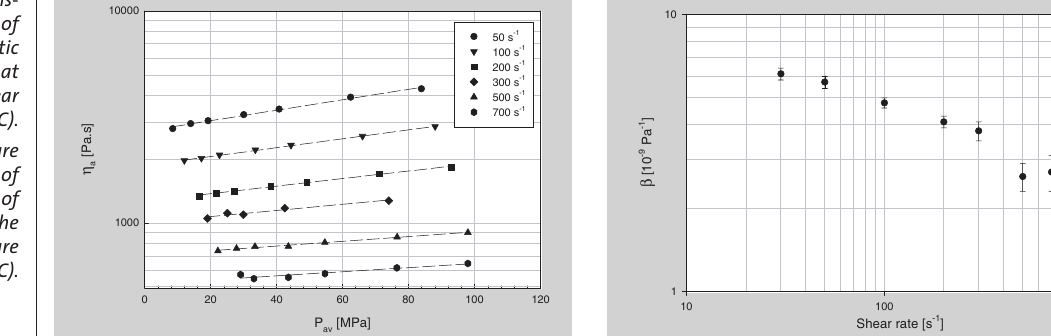
Figure 5 (left): Apparent vis- cosity as a function of increasing hydrostatic pressure for a LLDPE at different shear rates (190 0 C). Figure 6 (right): Pressure dependency coefficient of LLDPE as a function of shear rate, using the enhanced exit pressure technique (190 0